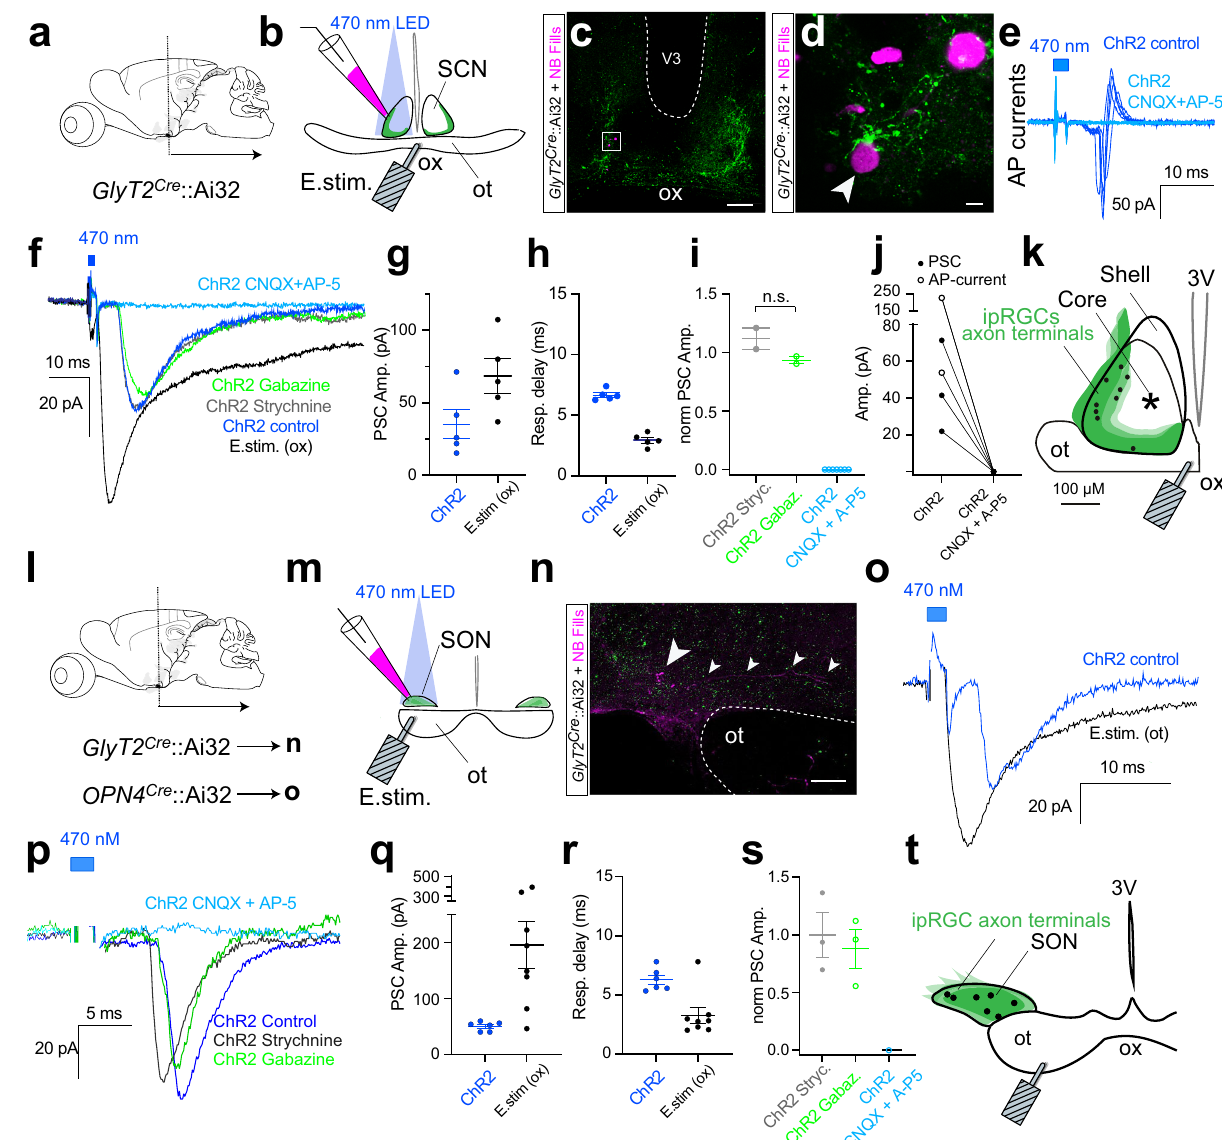
Fig. 8 | SON-ipRGCs release glutamate in the SCN and SON. a Brain slice recordings in the SCN performed in coronal sections of GlyT2 Cre ;Ai32 mice. b Confocal images of an SCN slice, immunostained following recordings illus- trating Neurobiotin- fi lled cells and EYFP-positive axon terminals. d Zoomed region from c . e Photo-stimulation-evoked action potential currents (dark blue) were abolished following in CNQX+AP-5. f Whole-cell voltage-clamp recordings of electrical- and ChR2-evoked inward post-synaptic currents (PSCs) in control, 1 μ M strychnine, 10 μ M SR-95531, and CNQX+AP-5. ChR2-evoked currents were abolished with CNQX (20 μ M) and AP-5 (50 μ M). g Response amplitude and h delay of ChR2- evoked (Left) and electrical-stimulation-evoked (E.Stim) PSCs in the same neurons ( n =5 animals). i ChR2-evoked response amplitude in strych- nine ( n =2 animals), SR-95531 ( n =2 animals), or CNQX+AP-5 ( n =7 animals) normalized to the control response amplitude (data were presented as mean values±SEM; ns p =0.6917; unpaired two-tailed t -test). j PSC amplitude before and after CNQX+AP-5. k Photoresponsive cell locations. l , m Coronal recording